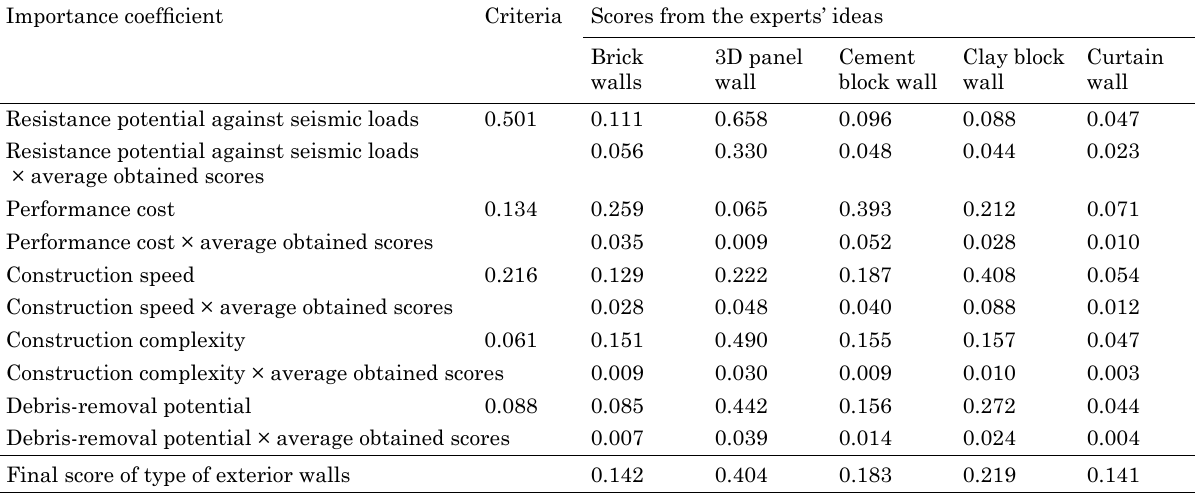
scores from the experts’ ideasCriteria importance